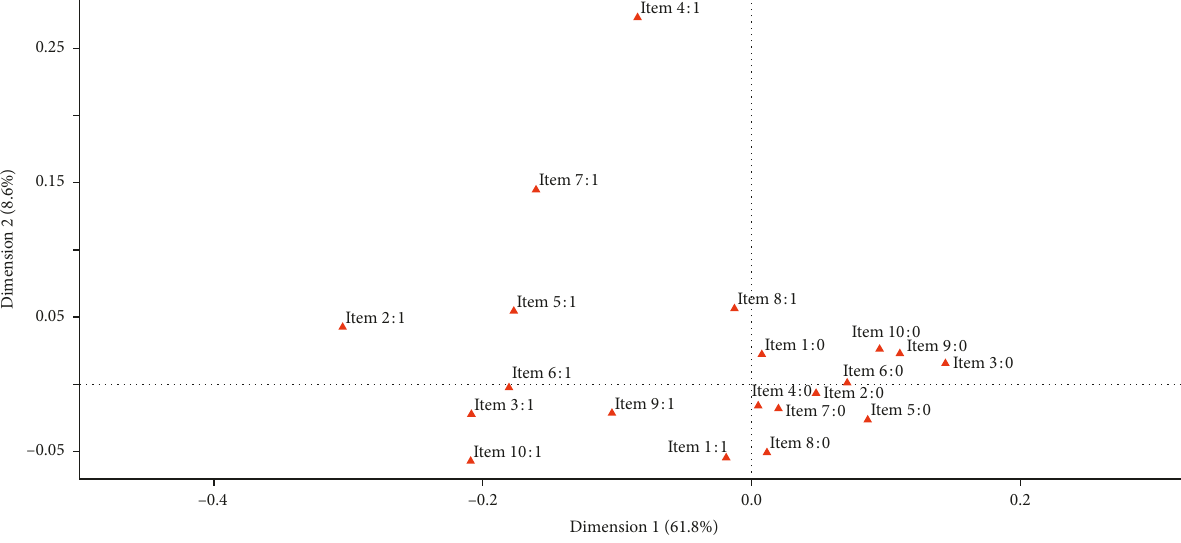
Figure 4: Graph of multiple correspondence analysis that highlights a homogeneity in the answer. Table 5: Results of a logistic regression models. Estimate Std.